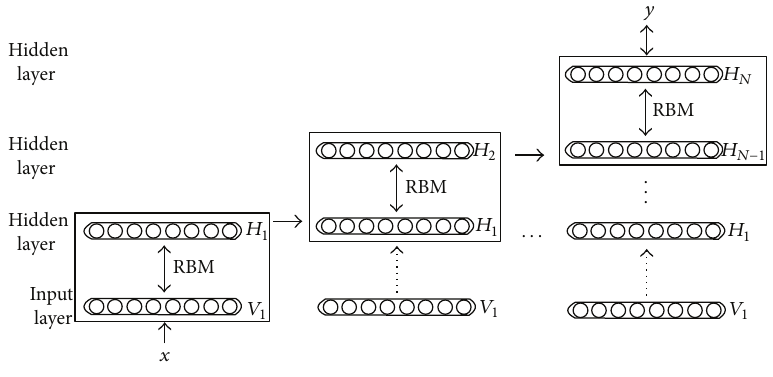
Figure 1: Architecture of deep belief network